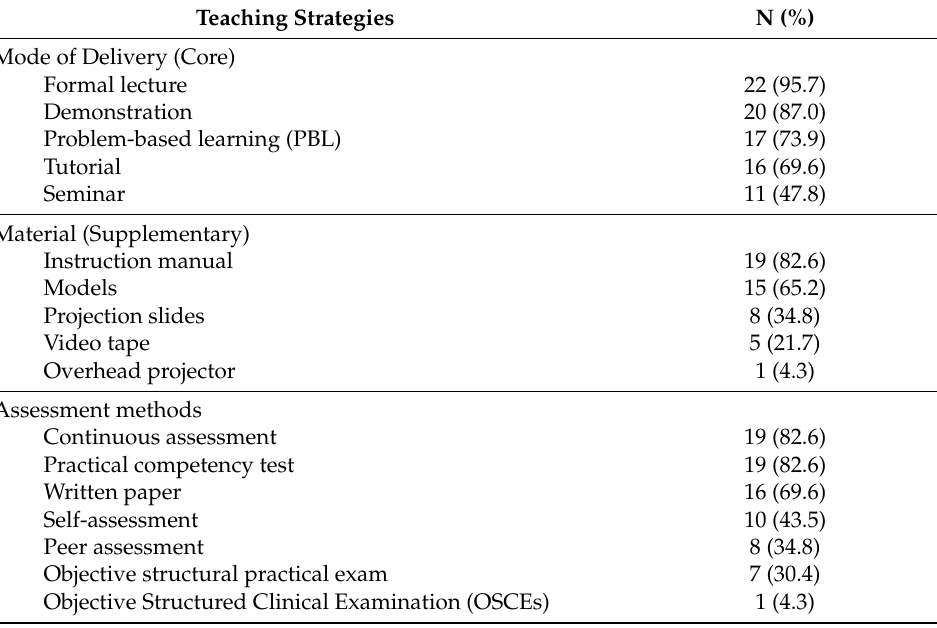
Table 1. Teaching strategies for posterior restoration ( n =